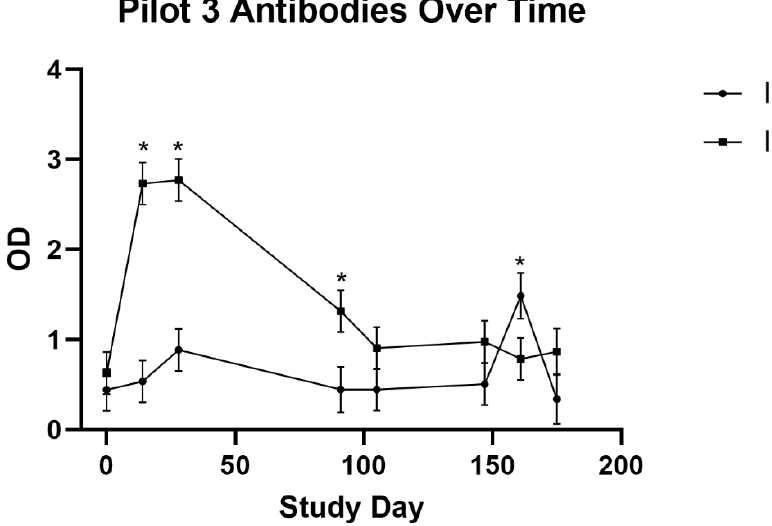
Figure 3. Antibody changes over time, as measured during Pilot 3. An asterisk (*) denotes significantly different ( p < 0.05) optical densities (OD), indicative of antibody concentration, for that study day.